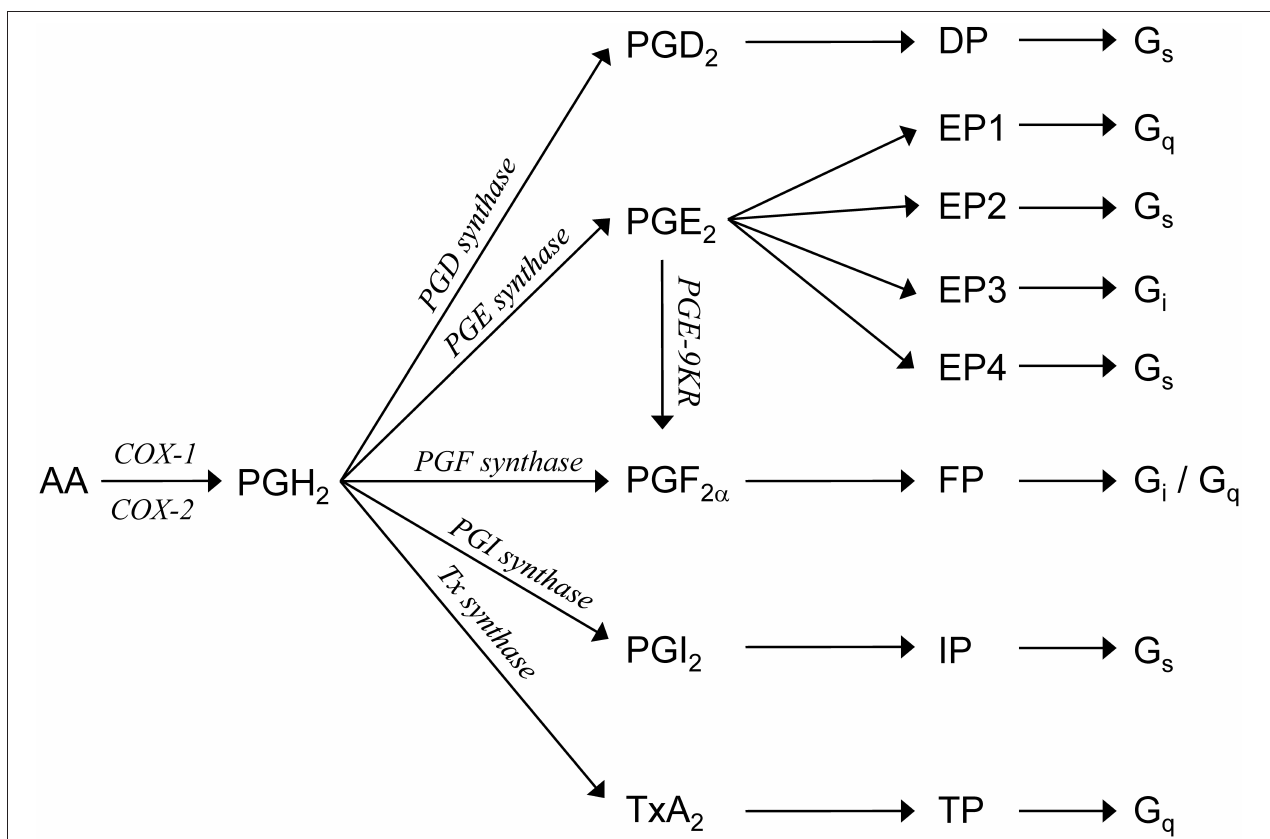
FIGURE 1 | Prostaglandin synthesis. Arachidonic acid (AA) is metabolized by COX1 or COX2 to PGH 2 . PGH 2 is enzymatically converted, by specific synthases [prostaglandin D (PGD) synthase, prostaglandin E (PGE) synthase, prostaglandin F (PGF) synthase, prostaglandin I (PGI) synthase, and thromboxane synthase] or prostaglandin E 9-ketoreductase (PGE-9KR), to one of five primary prostanoids, namely, PGI 2 , PGD 2 , PGE 2 , PGF 2 α , or TxA 2 . Each prostanoid interacts with distinct members of a subfamily of the G-protein-coupled receptors. PGI 2 activates the IP receptor, PGD 2 activates the DP receptor, PGF 2 α activates the FP receptor, and TxA 2 activates the TP receptor. PGE 2 interacts with one of four distinct EP receptors.